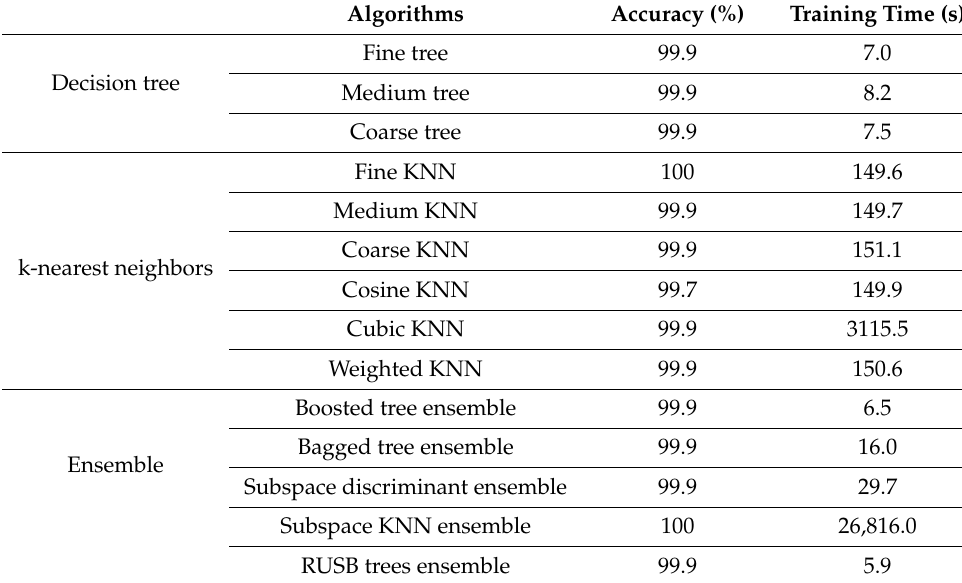
Table 7. Accuracy and training times of various machine learning algorithms employed.